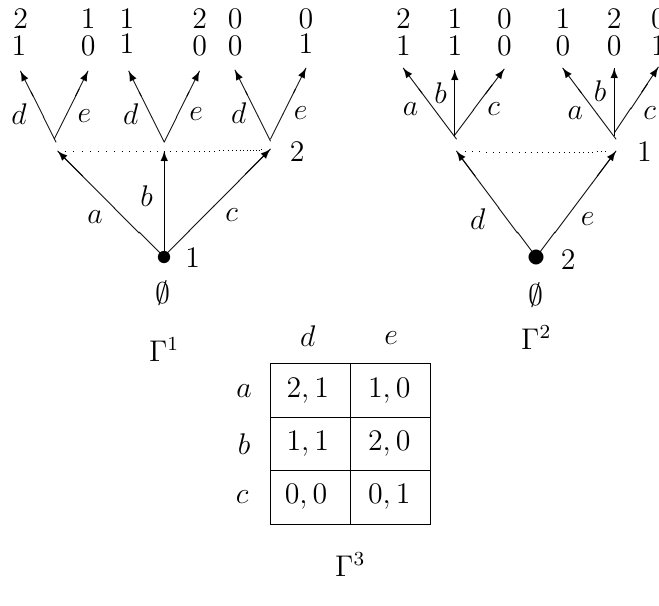
Figure 2. Chronological order of moves matters for “common belief in future